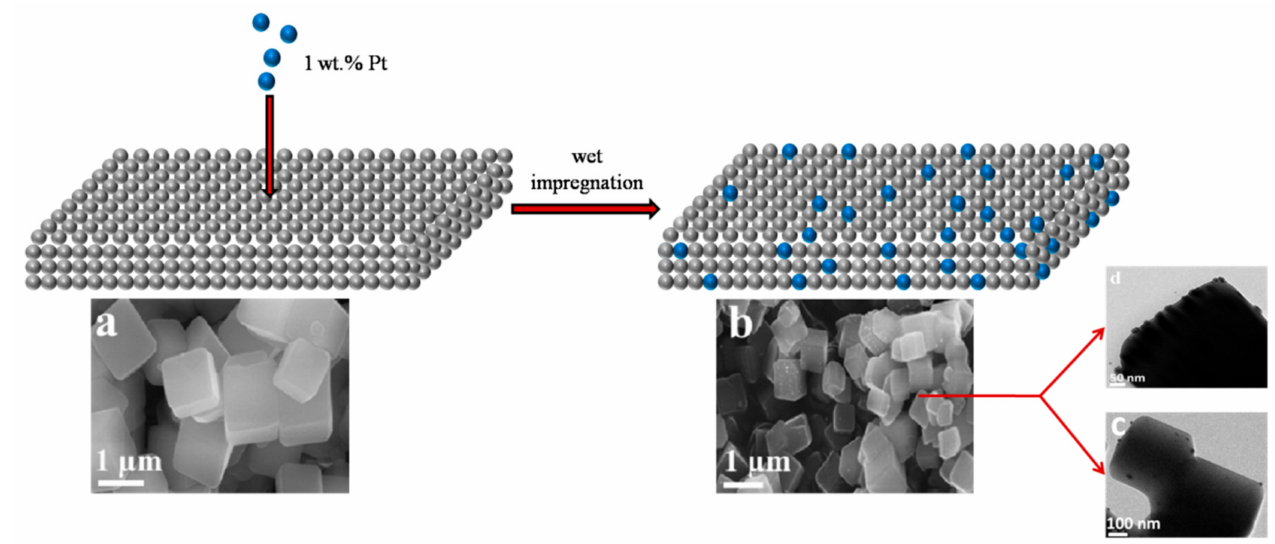
Figure 6. FE-SEM images of ( a ) ZIF-8 and ( b ) 1% Pt/ZIF-8, HR-TEM images of ( c ) 1% Pt/ZIF-8 with 50 nm scale and ( d ) 1% Pt/ZIF-8 with 100 nm scale